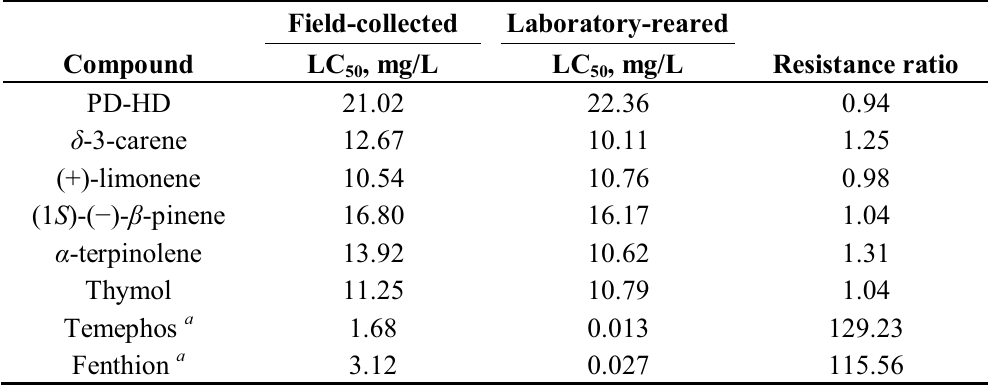
Table 4. Toxicity of Pinus densiflora hydrodistillate (PD-HD), five selected compounds and two commercially available synthetic larvicides against early third-instar larvae of field-collected and laboratory-reared Cx. p.